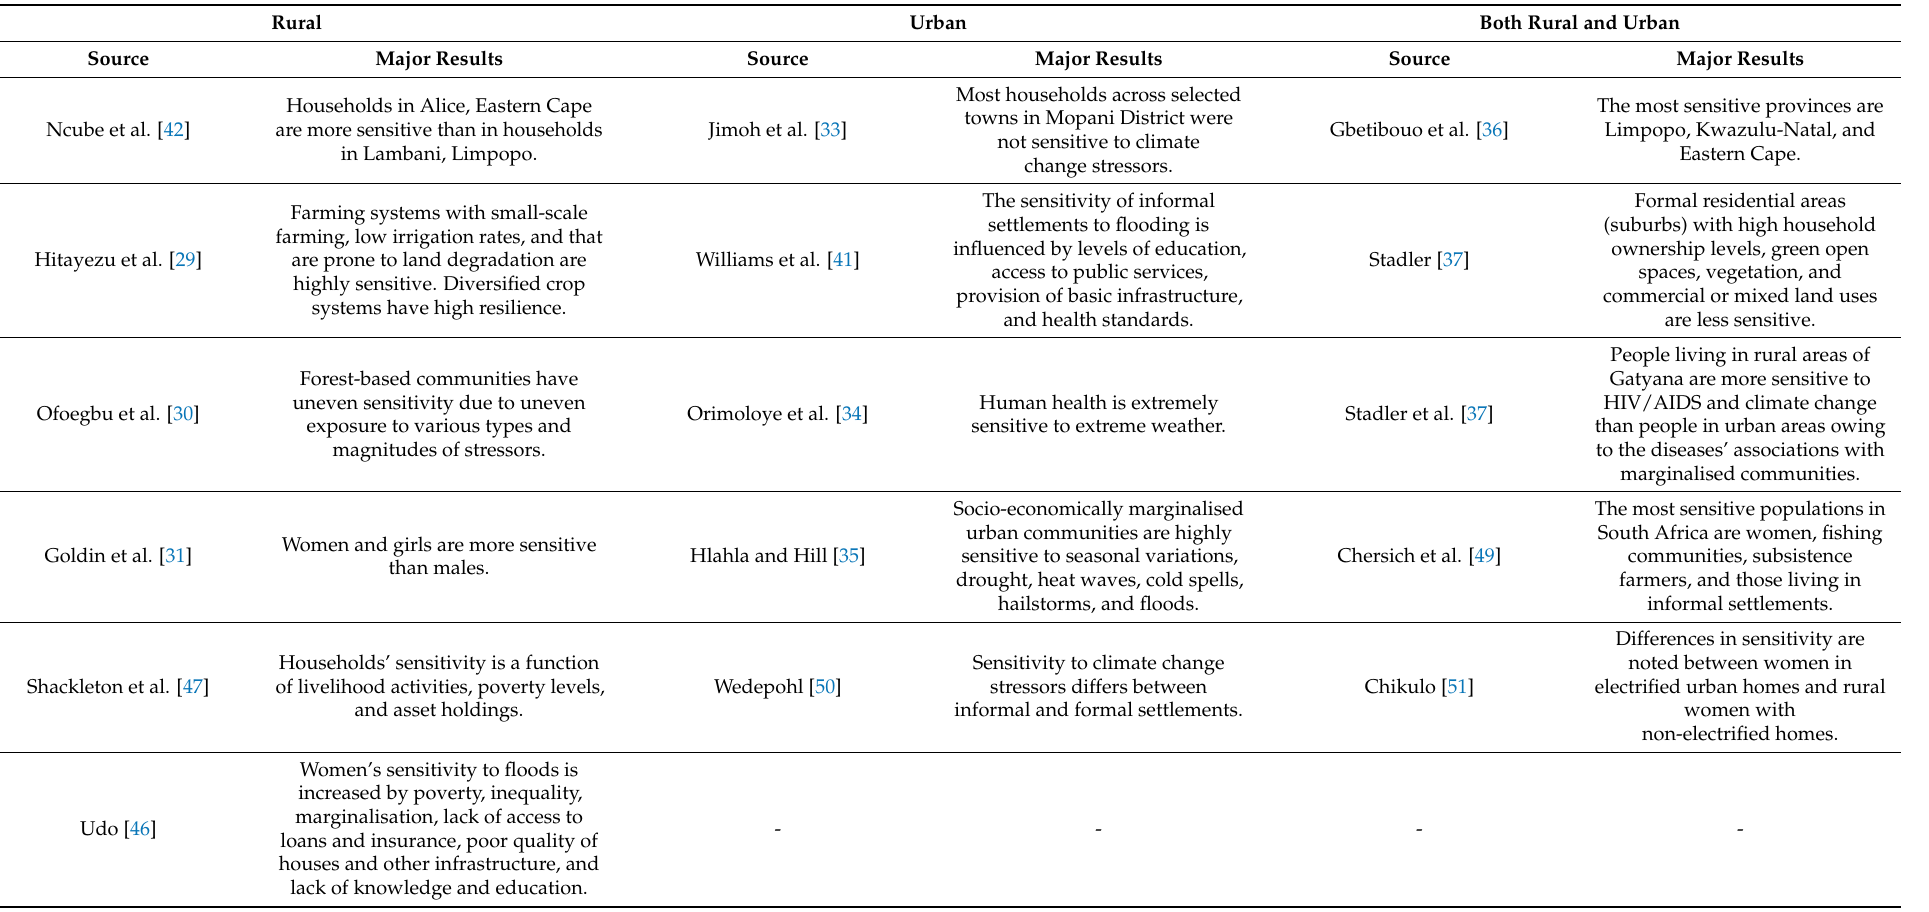
Table 3. Major results, reflections, and insights on sensitivity to climate change in rural and urban areas of South